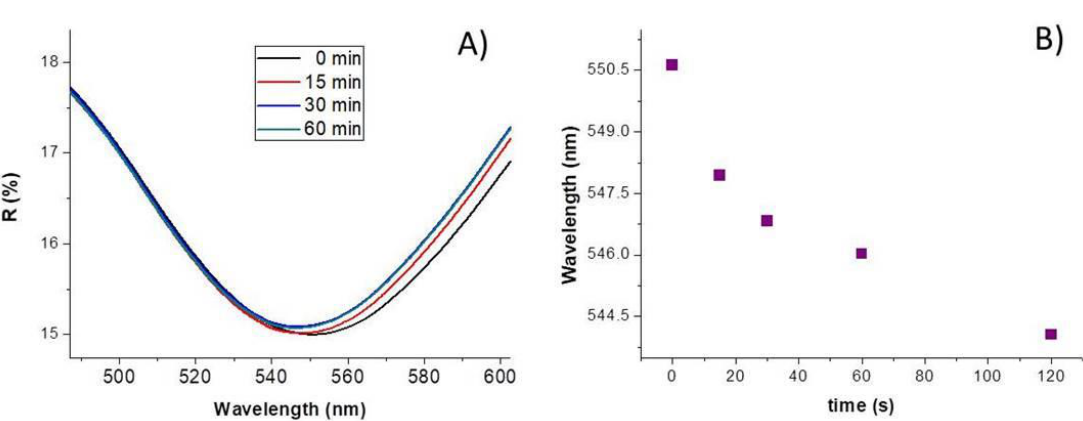
Figure 4. Comparison of UV-Vis diffuse reflectance spectra of AuNPs/TiO 2 layer in a 450–650 nm wavelength range at different exposure times to Hg 0 vapor pressure at 20 °C and 35%RH ( A ); a curve plot depicting the wavelength values of the AuNPs/TiO 2 layer at increasing exposure time to Hg 0 ( B ).